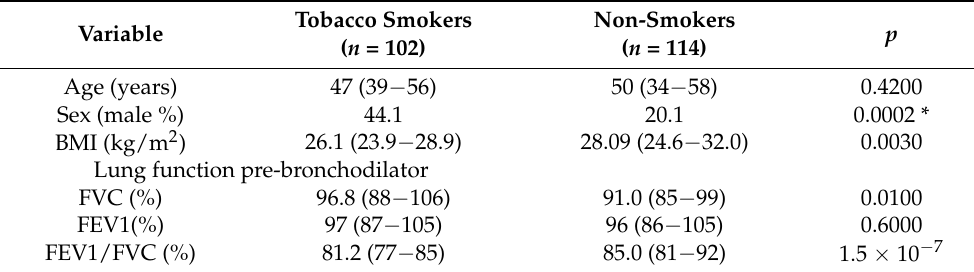
Table 1. Clinical and demographic overview of the studied groups.